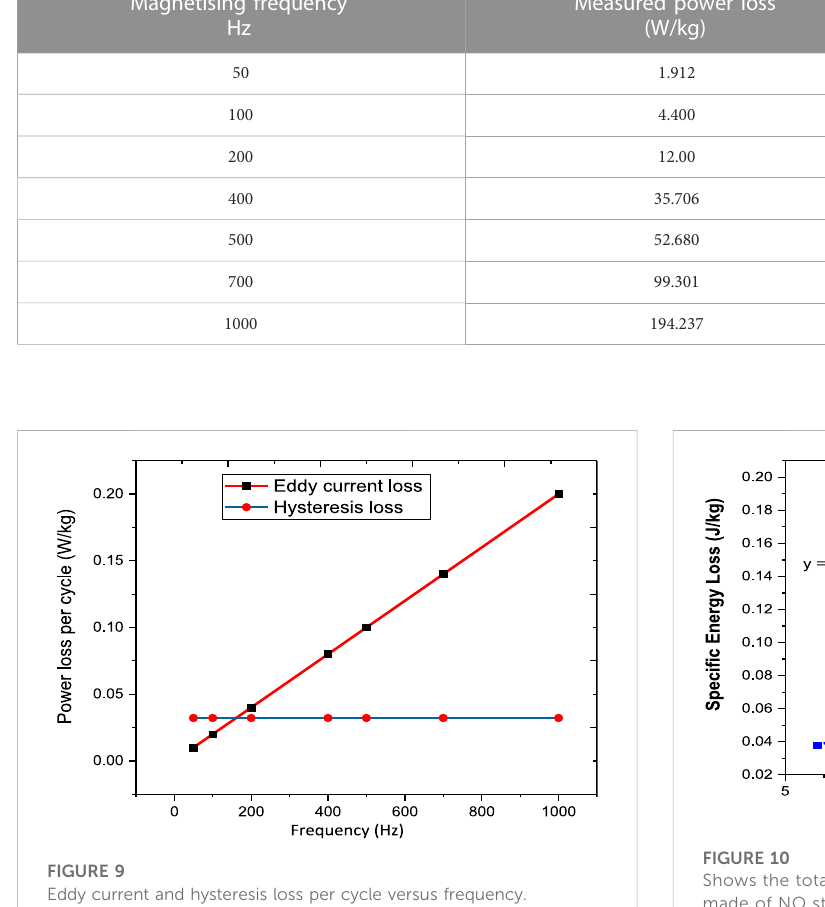
TABLE 6 Power loss of non-oriented steel is measured at a peak fl ux density of 1.5 T at different magnetizing frequencies with total power loss per cycle with coating. Magnetising frequency Measured power loss Hz (W/kg)